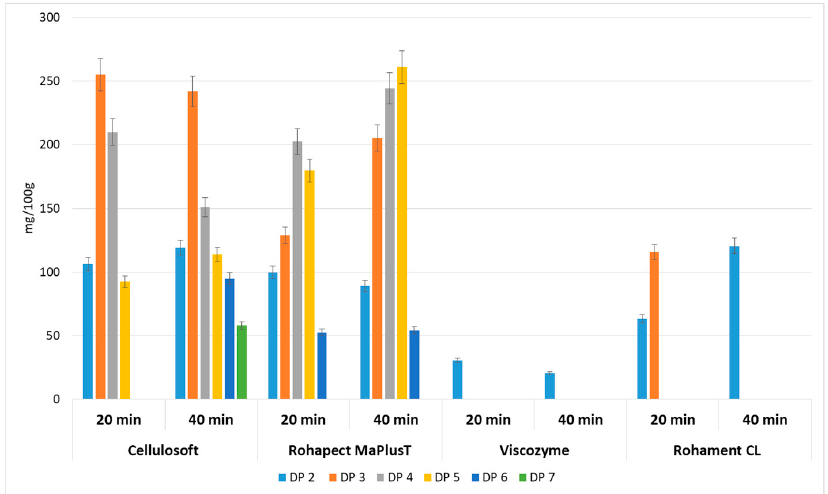
Figure 2. Yields of oligosaccharides with different degrees of polymerization obtained after enzymatic hydrolysis of apple pomace using cellulases and pectinases separately. Data represent mean from two independent experiments repeated three times. Error bars denote SD.